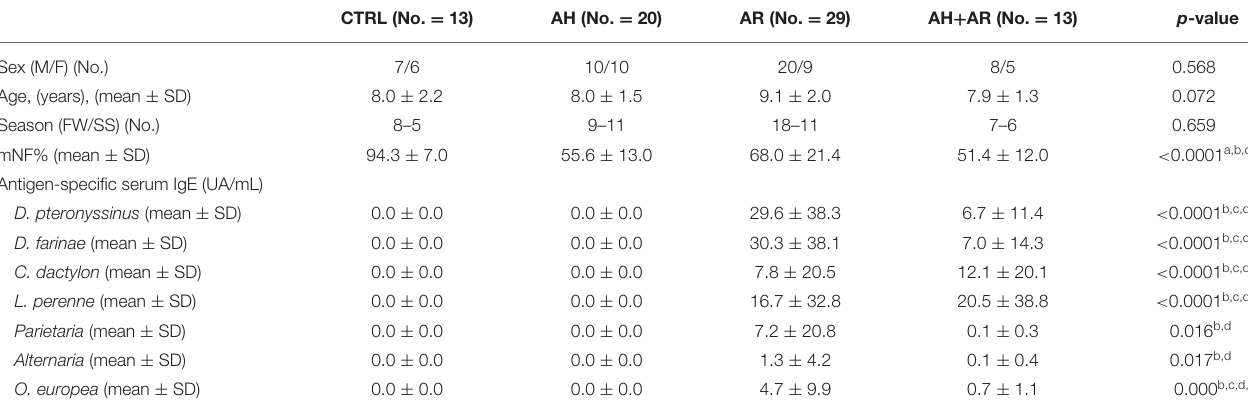
TABLE 1 | Characteristics of the studied population. CTRL (No. = 13) AH (No. = 20) AR (No. = 29) AH + AR (No. = 13) p -value Sex (M/F)